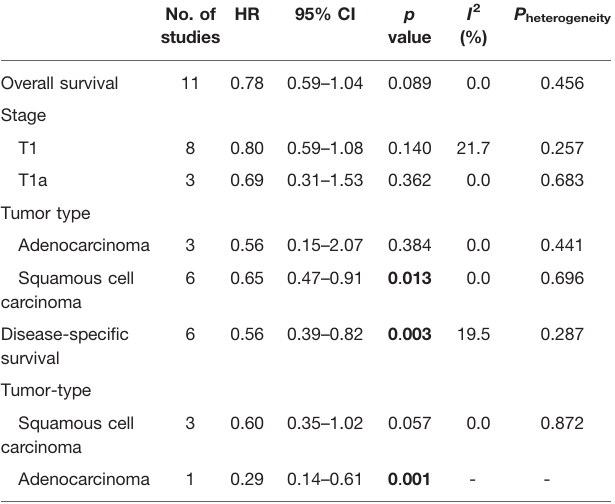
TABLE 2 | Results of meta-analysis.